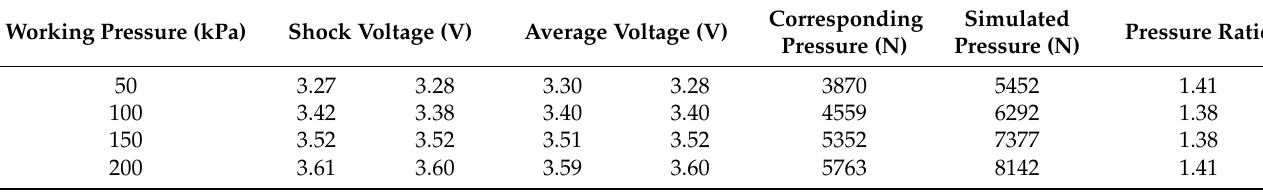
Table 5. Stone particle impact experimental data.